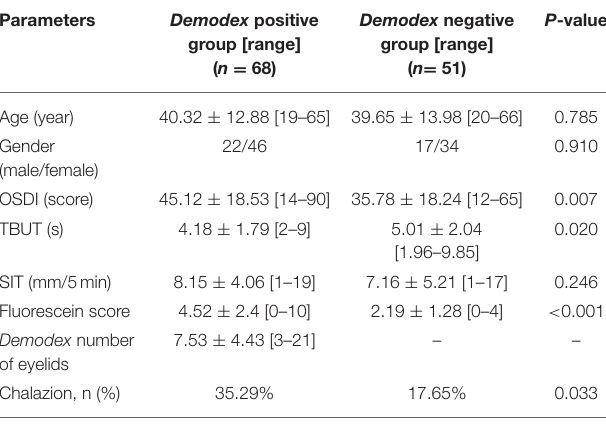
TABLE 1 | Characteristics of the study population.